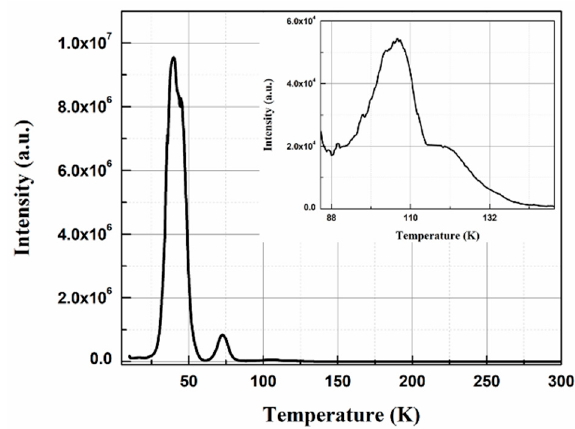
Figure 7. TSL glow curve of PMO-K2 measured after x-ray irradiation at 10 K and measured at heating rate of 0.1 K / s. The inset shows an enlarged view of 80–150 K region.